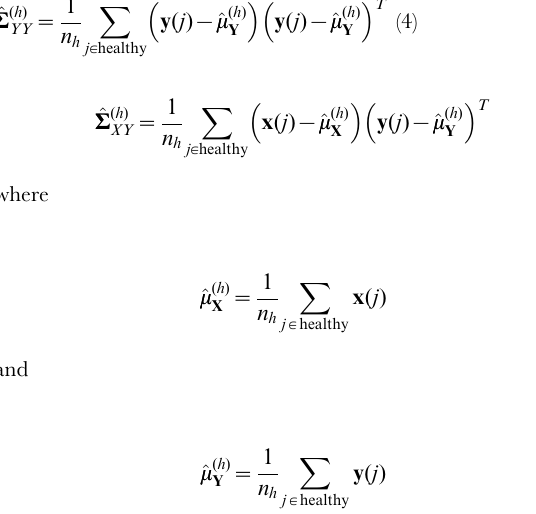
Figure S1 p -value heatmaps, showing the association of the DNAm network correlation measure with patient overall survival outcome, for the BRCA data set. For the BRCA data set, for each network edge (DNAm network interaction correlation measure), the Cox regression p -value (adjusted for clinical covariates) of association with patient survival outcome is displayed according to the colour scale shown on the right. (a) p -values are calculated for every possible pair of genes of the 14800 available in this data set, with genes clustered along the margins of the plot using these p -values as a distance measure. (b) Null p -values are generated by sampling from a uniform distribution bounded on [0,1] for every possible pair of genes, with genes similarly clustered along the margins. (c) and (e) p -values are calculated for the 8614 genes which appear in this data set and also in the pathway commons interactome map, for the 276136 interactions between pairs of these genes defined by this interactome map. Genes are similarly clustered along the margins of the plot according to p -value. (e) Shows a zoomed-in view of the top-left of (c). (d) and (f) are as (c) and (e), but based on null p -values randomly sampled from a uniform (0,1) distribution, to demonstrate the structure present from the pathway commons interactome map, without the influence of the DNA methylation network interaction measure. Pearson correlation coefficients comparing values in these adjacency matrices as plotted, are as follows: (a) vs. (b), 0.0011; (c) vs.